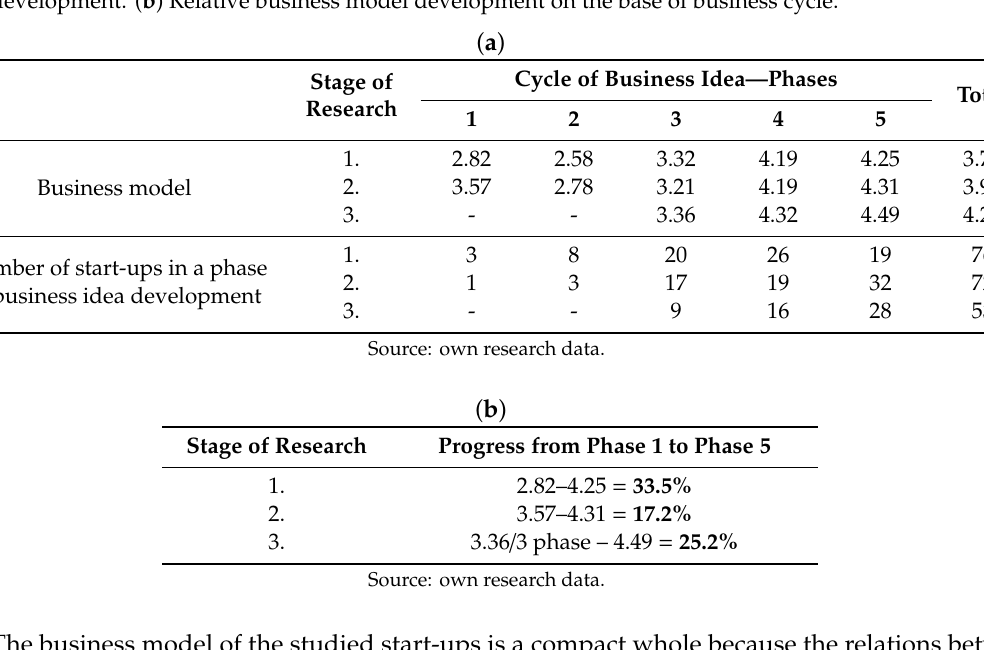
Table 2. ( a ) Average degree of business model development in particular phases of business idea development. ( b ) Relative business model development on the base of business